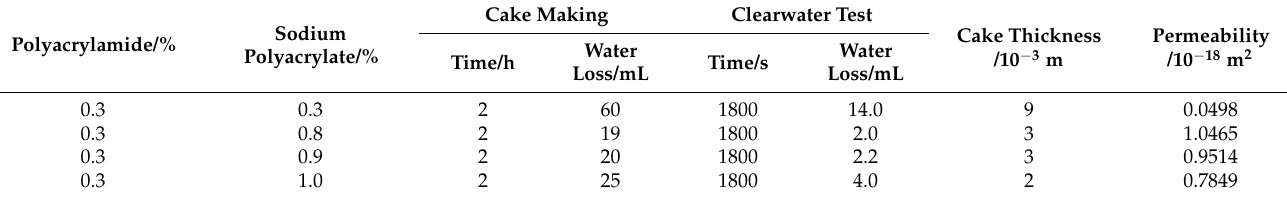
Table 3. Experimental results for synthetic clay cake with composite barite base slurry.